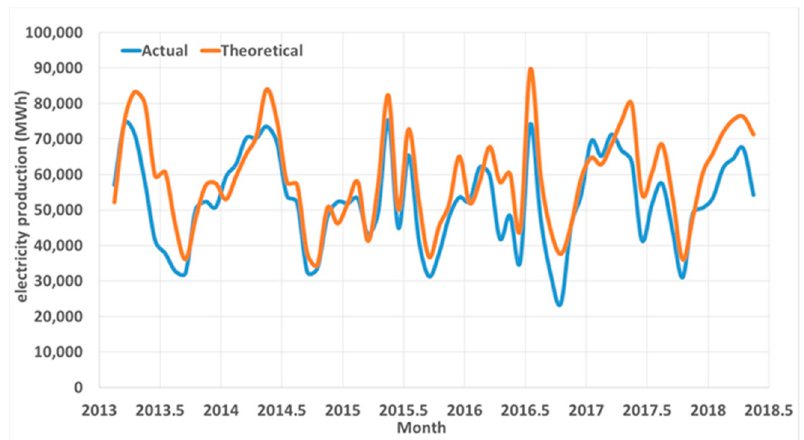
Figure 3. Los Vientos 1A actual electricity production (public domain data from [50]) and theoretical electricity production. X time, years; Y electricity production, MW·h.